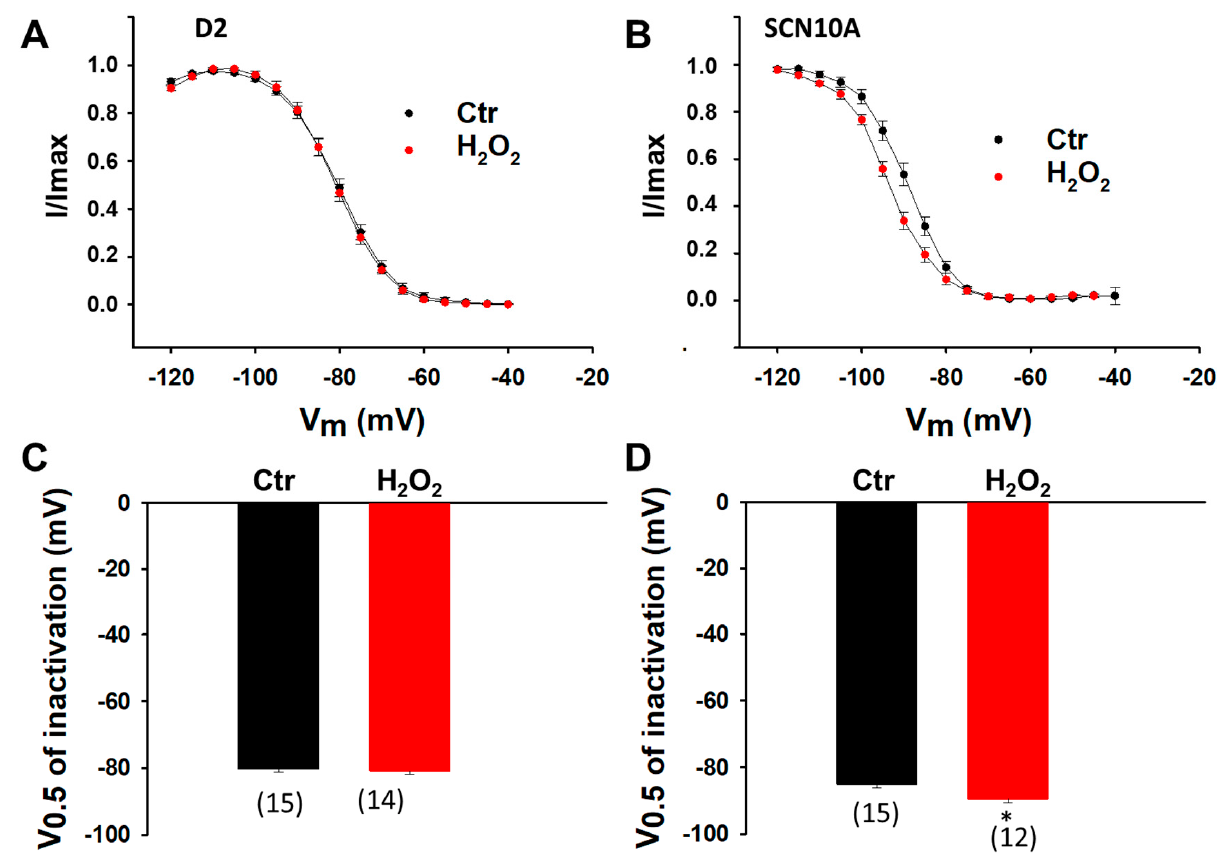
Figure 10. Effects of H 2 O 2 on inactivation of sodium channels in hiPSC-CMs from BrS-patient. Cells were treated with vehicle (Ctr) or H 2 O 2 (200 µ M) for 2 h. ( A ) Inactivation curves of peak sodium channel currents (I Na ) recorded in hiPSC-CMs from the D2 healthy donor. ( B ) Inactivation curves of peak I Na recorded in SCN10A-hiPSC-CMs. ( C ) Mean values of potential at 50% inactivation (V0.5) in hiPSC-CMs from D2 healthy donor. ( D ) Mean values of potential at 50% inactivation (V0.5) in SCN10A-hiPSC-CMs. Numbers given in ( C , D ) represent the number of cells of measurements also for ( A , B ). * p < 0.05 versus Ctr according to t -test for two groups.